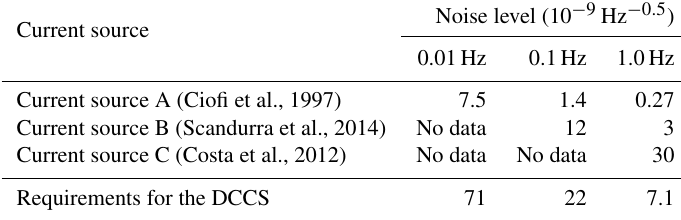
Table 1. Noise level of some digitally controlled current